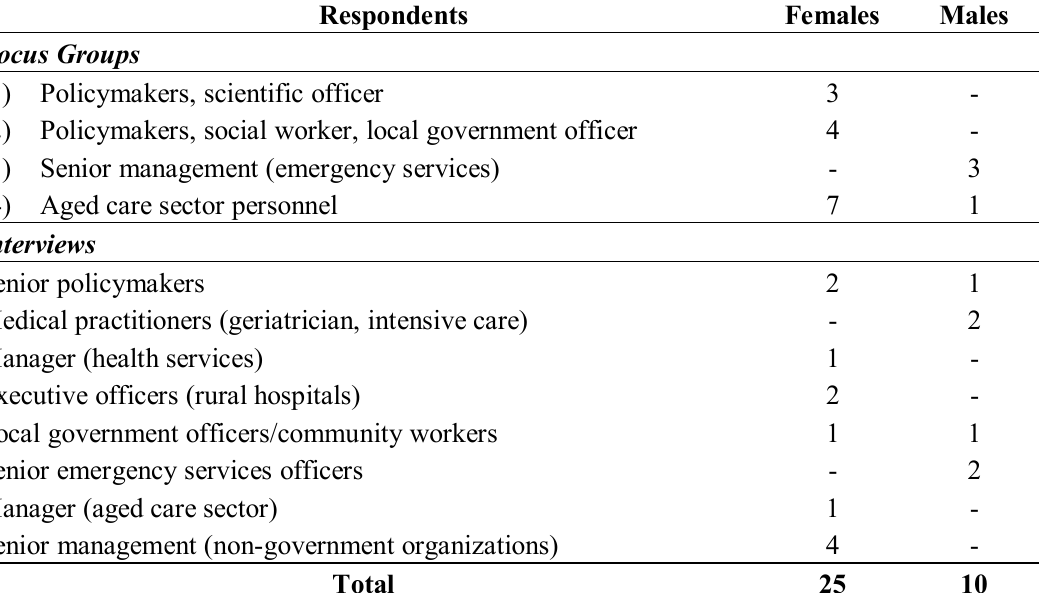
Table 1. Respondent